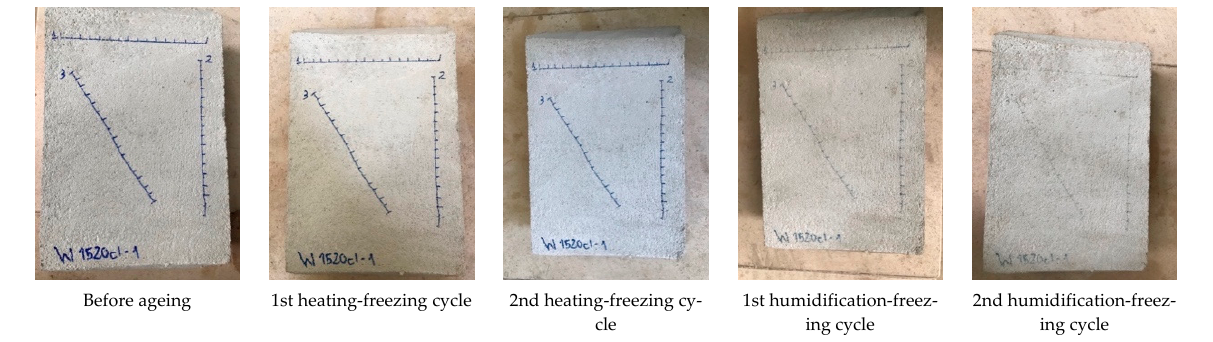
Figure 15. Visual aspect of the wool fibre cement-lime mortar during the artificial ageing test.